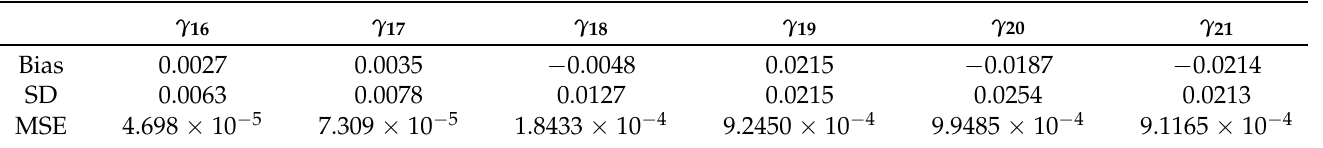
Table 10. Bias, SD and MSE evolutions with respect to the parameter γ variation for GNFPLSIM with the logistic link function and n =